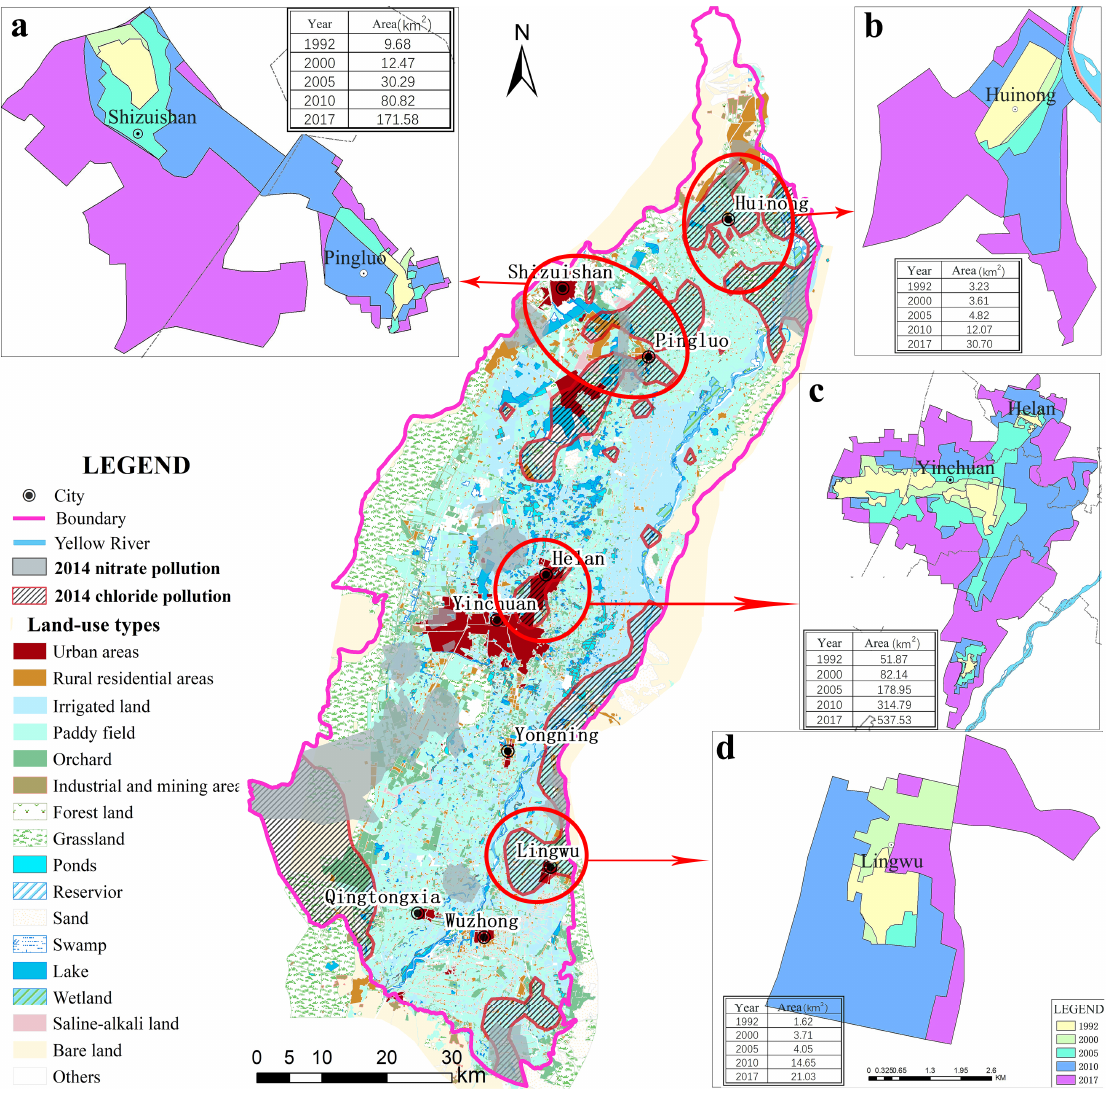
Figure 9. Map of land use types and the spatial distribution of nitrate and chloride pollution and urban expansion in 1992, 2000, 2005, 2010, and 2017. Spatial distribution of urban expansion of: ( a ) Shizuishan, ( b )Huinong, ( c ) Yinchuan, and ( d ) Lingwu.